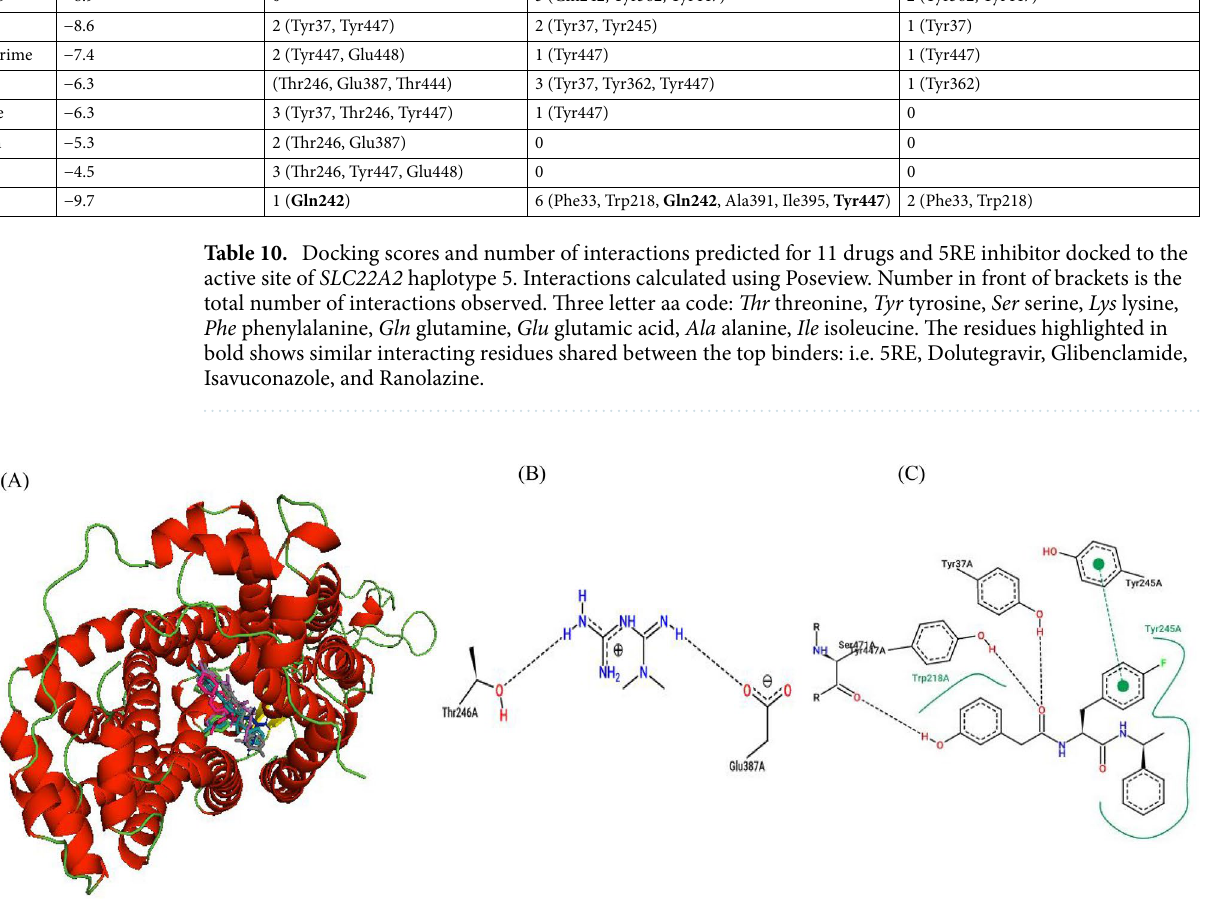
Figure 6. Ligand overlay for haplotype 1 SLC22A2 protein. ( A ) Image was generated using Pymol with the first line anti-diabetic drug, Metformin, shown in blue. The four top binding ligands Isavuconazole, Dolutegravir, Glibenclamide, and Gliclazide are shown in deep teal, grey, hot-pink and green respectively. The 5RE inhibitor is indicated in magenta. ( B,C ) 2D PoseView illustration, showing interacting residues for Metformin and the 5RE inhibitor respectively—dotted black lines denote hydrogen bonds, solid green lines denote hydrophobic interactions and dotted green lines denote π stacking &/or aromatic